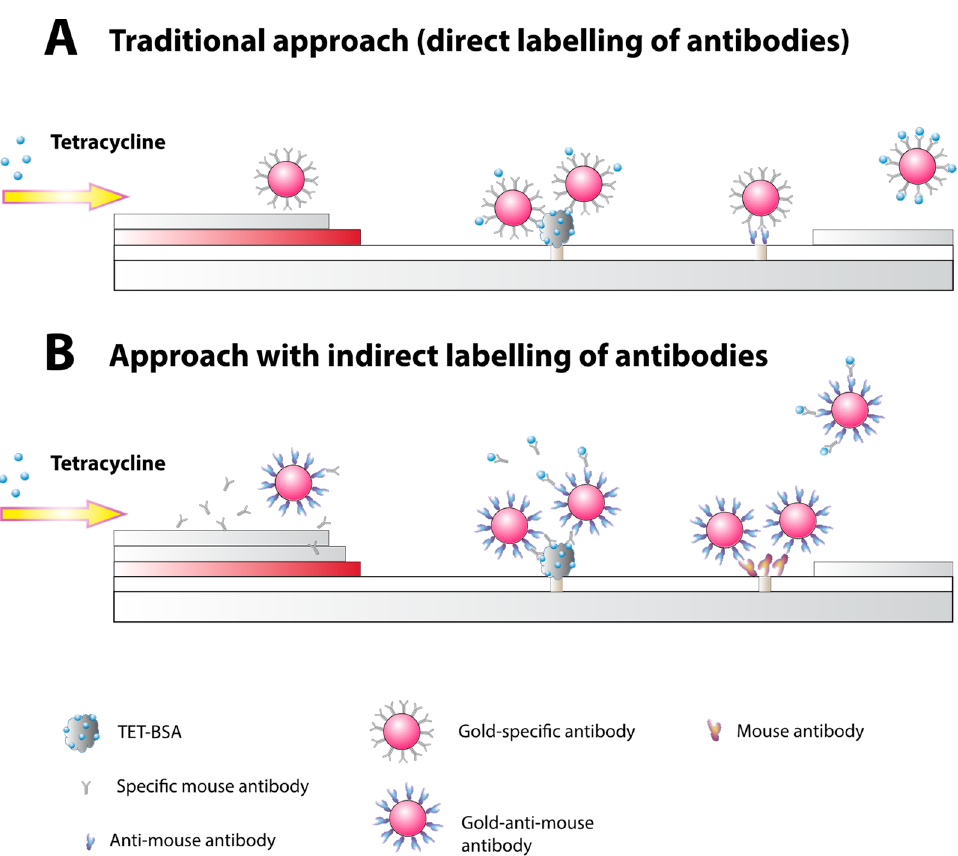
Figure 2. Principle of immunochromatographic determination of TET in human serum: ( A ) with direct immobilization of antibody to the gold nanoparticles; ( B ) with application of native specific antibody and conjugated anti-species antibody.